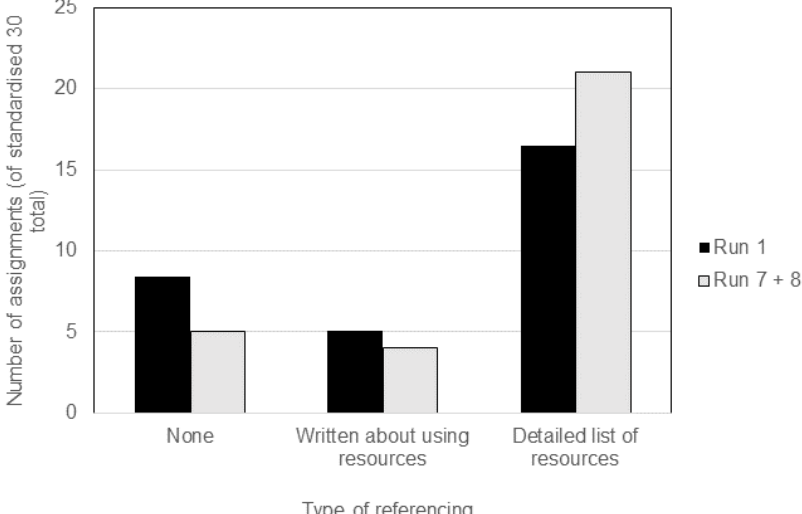
Figure 2. Change in the predominant type of referencing in learner summary assignments between Run 1 and Runs